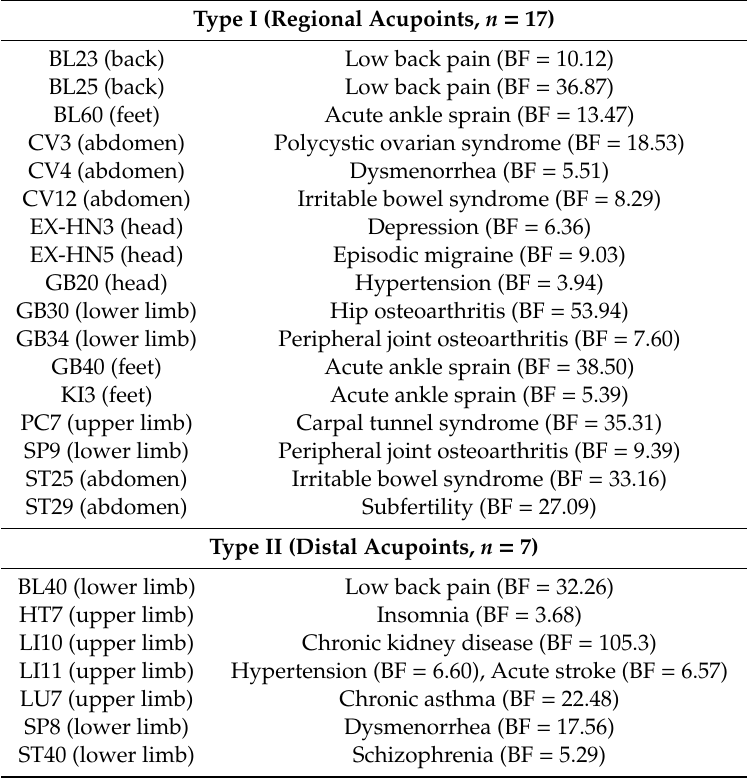
Table 1. Classification of acupoint indications with strong inference (BF > 3).